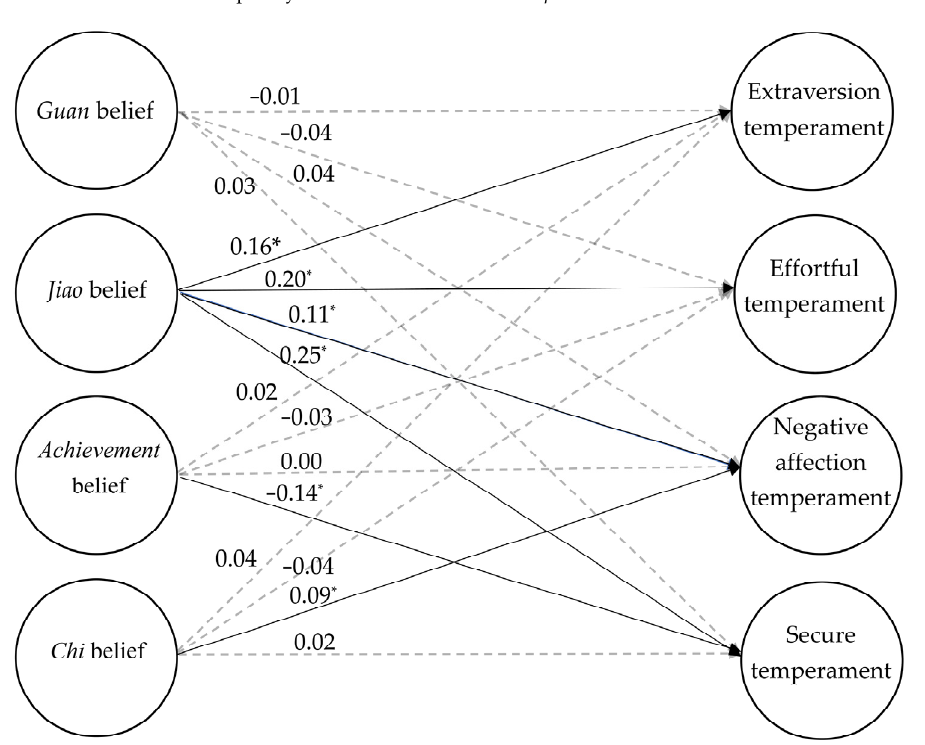
Figure 1. The graphical representation of the effects of Chinese parenting beliefs on temperament and secure attachment. * p < 0.05.